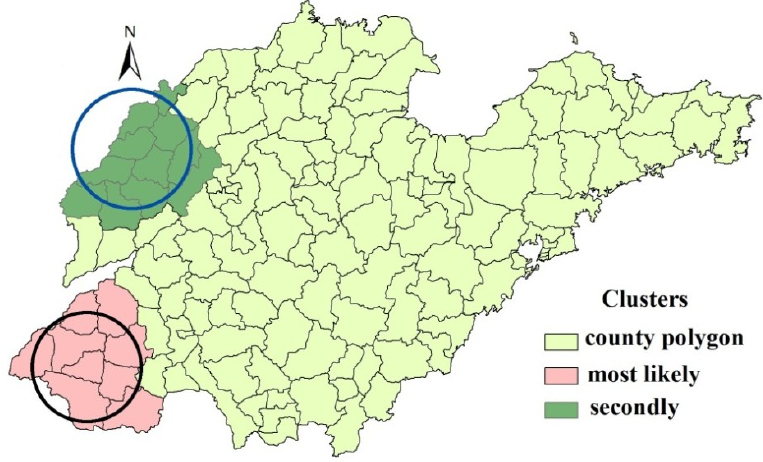
Figure 4. Spatial distributions of the detected clusters of high iodine areas in Shandong Province, China.